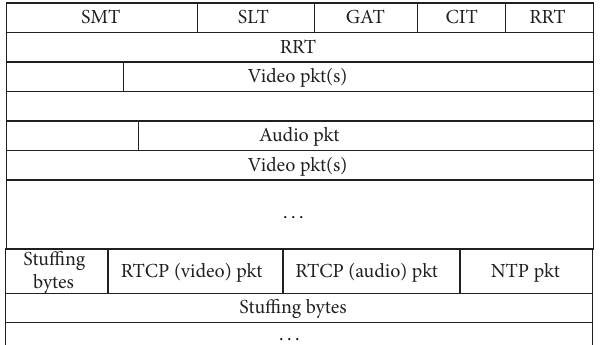
Figure 2: Typical RS frame payload